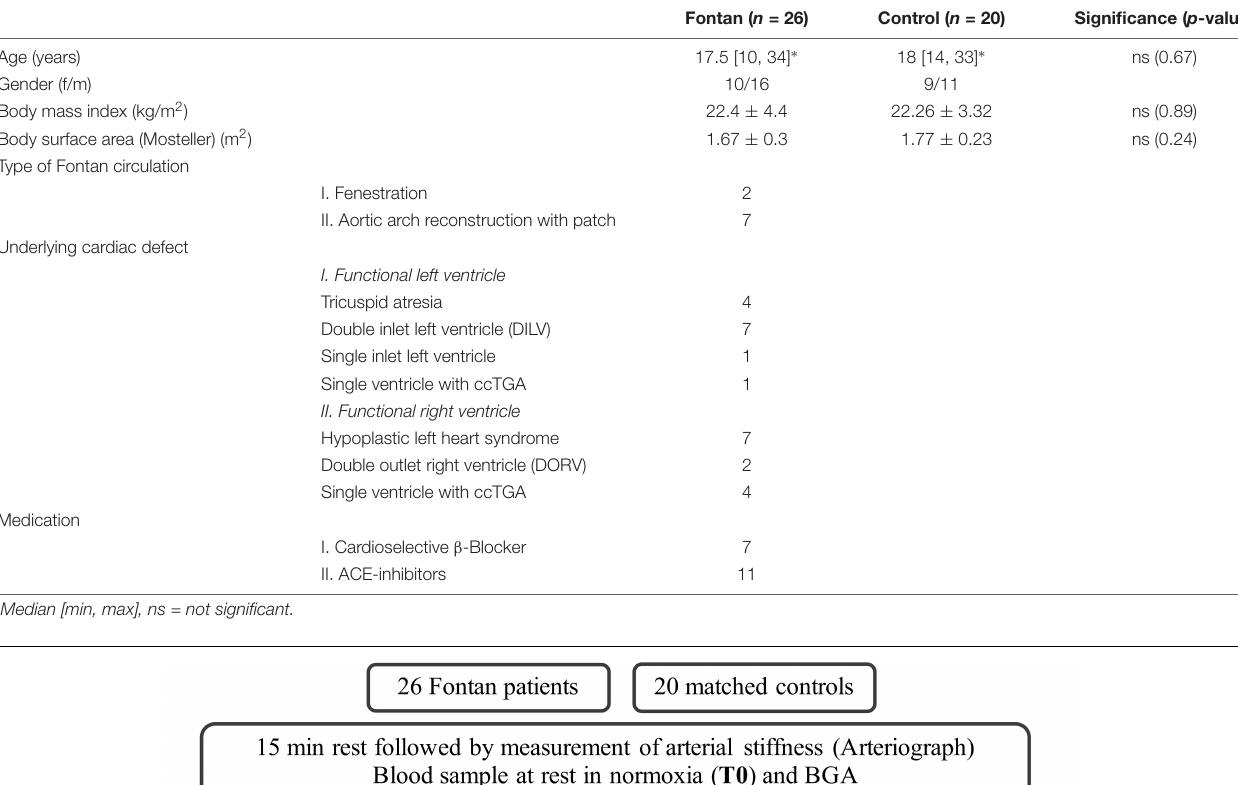
TABLE 1 | Participant’s characteristics.